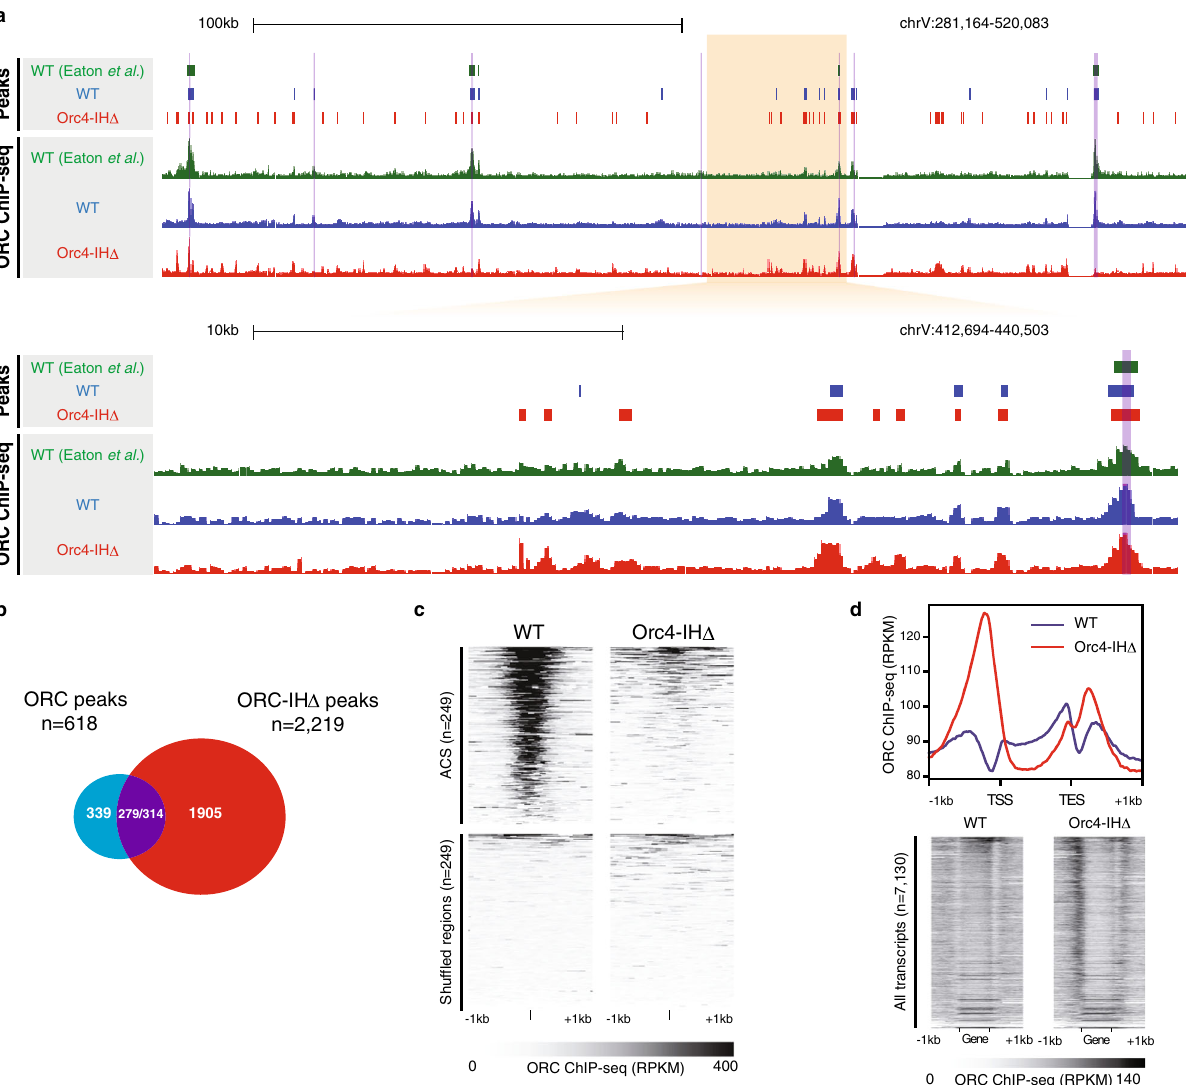
Fig. 3 Orc4-IH motif deletion alters the DNA-binding speci fi city of ORC. a Genome browser screenshots illustrate the enrichment patterns of ORC across the yeast genome. Normalized signals (Reads per kilobase per million reads (RPKM)) of WT ORC (blue), ORC-IH Δ (red), and previously published ORC ChIP-seq datasets (green) 13 are shown alongside their corresponding peak calls. Y -axis for all ChIP-seq tracks within the screenshot are set to the same scale. b Venn diagram showing the overlap between ORC ChIP-seq peaks de fi ned in WT ( n = 618; blue) and Orc4-IH Δ cells ( n = 2219; red). Of these, 279 ORC and 314 ORC-IH Δ peaks overlapped by at least 1 bp (purple), while 339 and 1905 peaks were identi fi ed as unique in WT and Orc4-IH Δ , respectively. c Heatmaps show the ORC enrichment patterns in WT and Orc4-IH Δ at regions containing previously de fi ned ACS (±1 kb of ACS; top). Size- and number-matched shuf fl ed genomic loci were included as controls (bottom). d Line plot and heatmaps show the ORC enrichment patterns in WT and Orc4-IH Δ at annotated transcripts and fl anking sequences. The line plot (top) shows the aggregated ORC ChIP-seq signal (RPKM) at all annotated transcripts and the surrounding regions (±1 kb). Orc4-IH Δ binding (red) at the 5 ′ of the transcriptional start site (TSS) is dramatically higher than that of WT (blue). Heatmaps (bottom) also demonstrate the differential enrichment of Orc4-IH Δ upstream of the TSS. The transcripts in the heatmaps are arranged by descending RNA-seq signals, indicating the association of mutant ORC binding at these loci and the expression